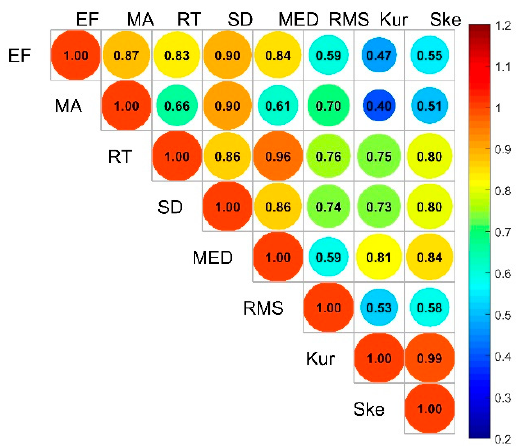
Figure 6. The relevance between features and features under the same label.